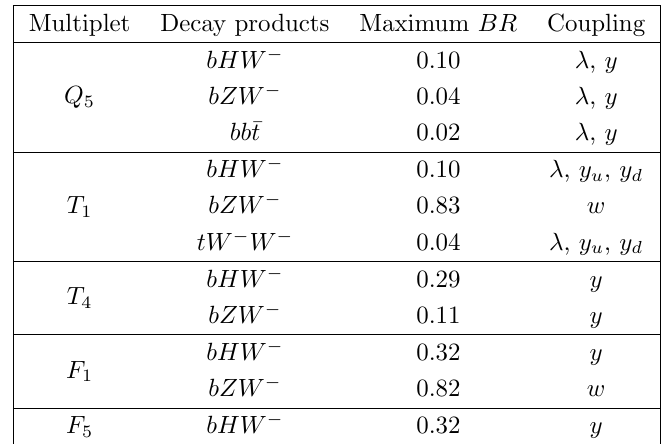
Table 10 . Decay channels of X other than W + t with branching ratio larger than 0.01 for M = 2 TeV, when the couplings (cid:21) are (cid:12)xed to the values that saturate electroweak precision limits. The last column displays the coupling constant which, when set to (2 TeV) (cid:0) 1 , gives the maximum BR in the corresponding channel. The appearance of (cid:21) indicates that the channel in question is present already in the case with dimension-4 interactions only.